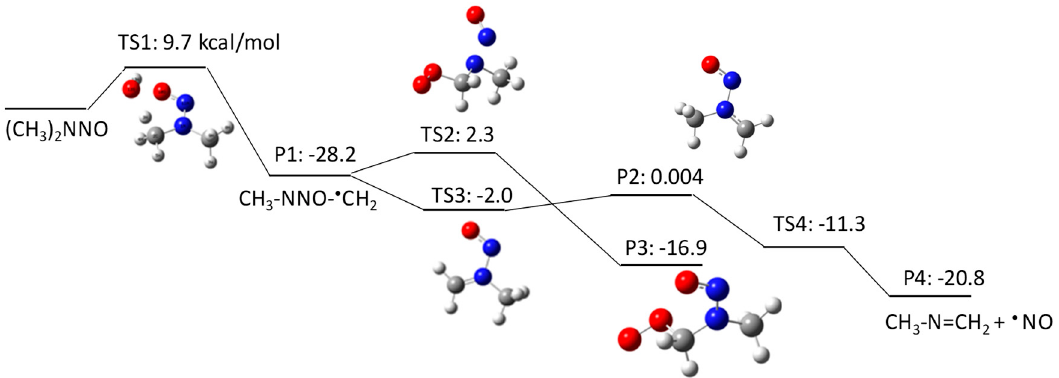
Figure 1. Free energy profile for pathway 1–1 of the HO • -induced reaction pathways for N -nitrosodimethylamine (NDMA) via H abstraction. TS denotes the transition state, and P denotes the product. The numbers (kcal/mol) are the free energy of activation for the TS and free energy of reaction for the P relative to the corresponding